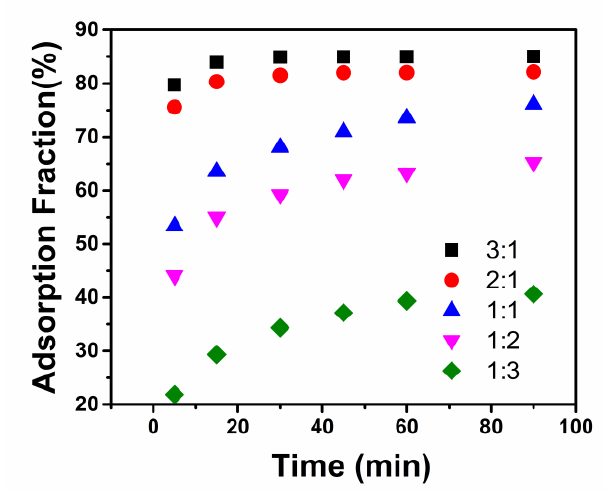
Figure 5. Adsorption rates of AMPS – DMAA copolymers with different charge densities. The zeta potential values of the fresh cement pastes mixed with different copolymers were also tested (Table 3). It could be observed that the addition of the AMPS–DMAA copolymers with negative charge decreased the surface potential of cement particles. The values of zeta potential decreased with the increasing negative charge density of the AMPS–DMAM copolymers. The zeta potential values were consistent with the results thus, the value of zeta potential was lower. Table 3. Zeta potential values of the cement pastes mixed with different copolymers. Molar Ratios